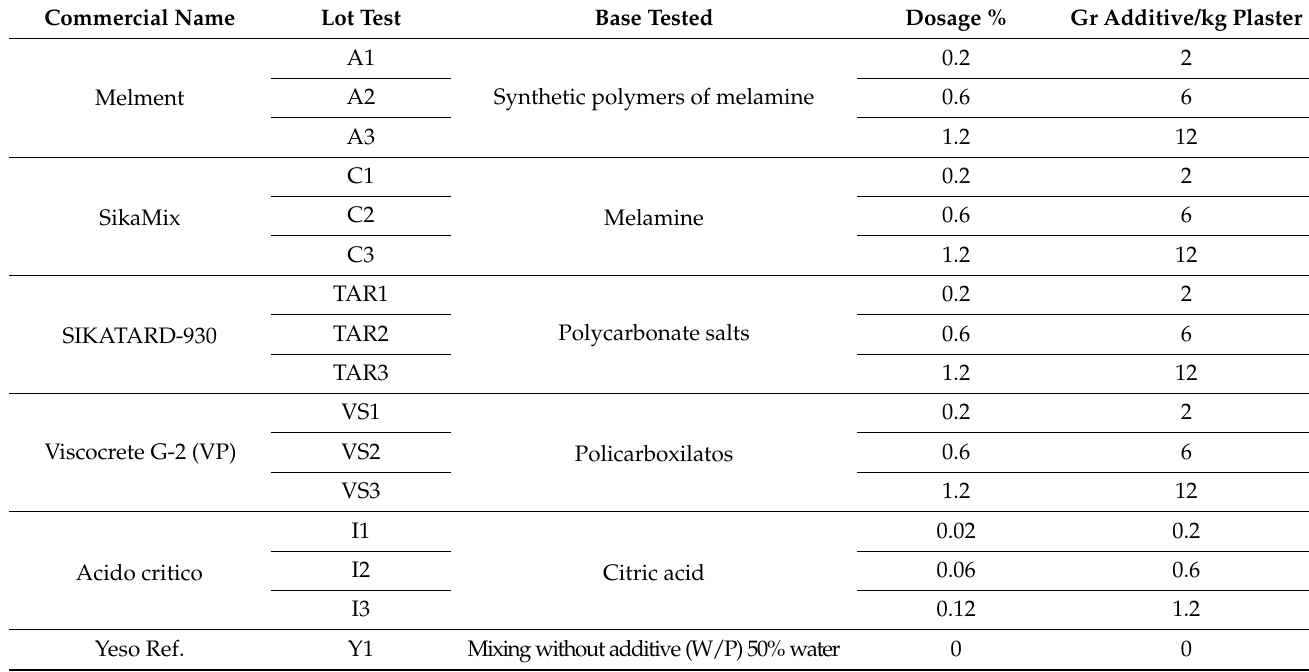
Table 3. List of batches tested and dosages used. The results are expressed in % (W/P) with respect to the weight of the gypsum